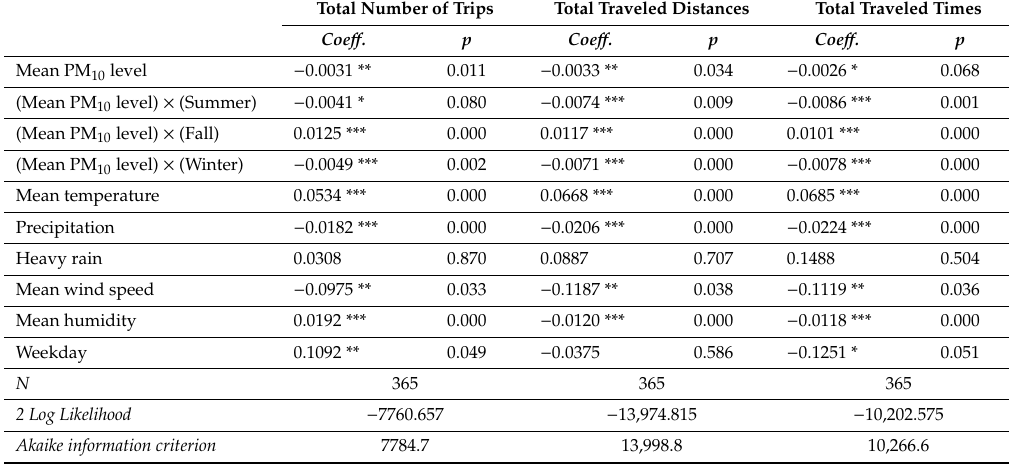
Table A1. Estimation results for bike sharing using multiplicative interaction variables for seasons and PM 10 level data.